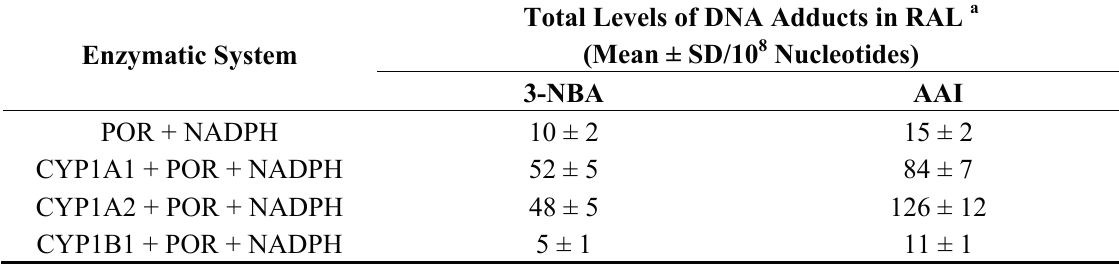
Table 2. DNA-adduct formation by 300 μ M 3-NBA and AAI activated by human recombinant POR, CYP1A1, 1A2 and